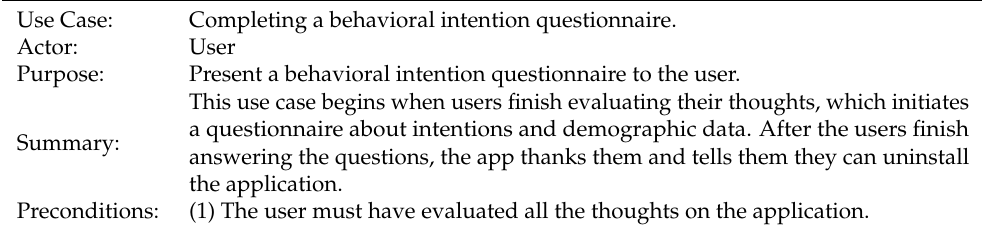
Table 2. General use case: completing a behavioral intention